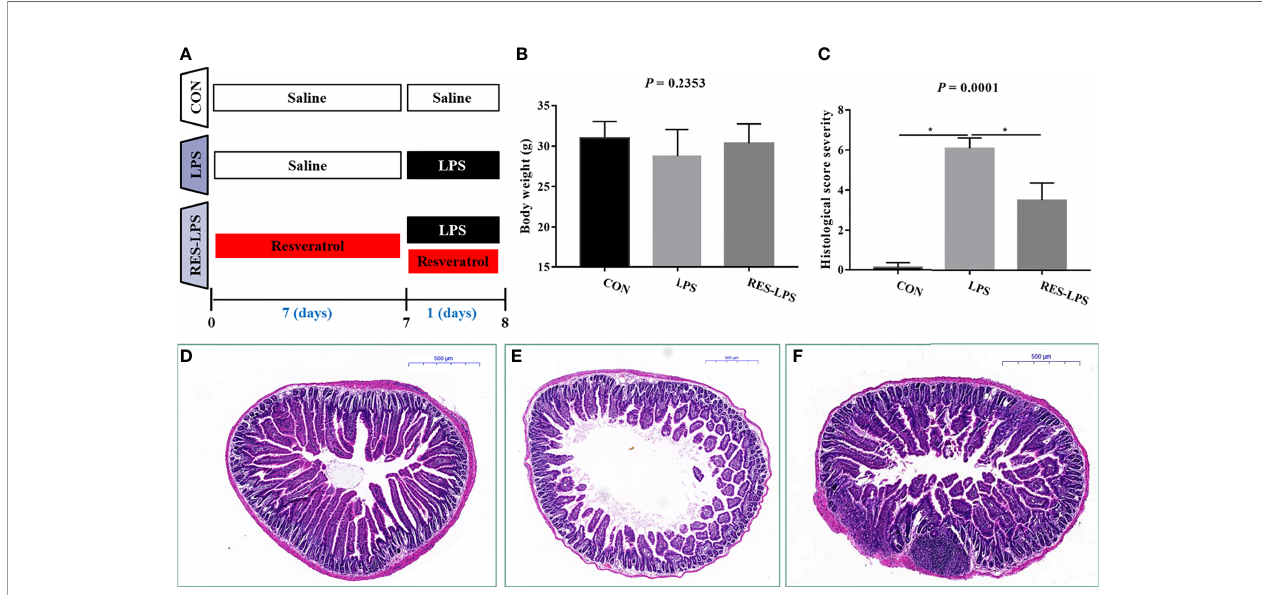
FIGURE 1 | Effect of RES on intestinal in fl ammation induced by LPS. (A) Timearrangement and treatment ofthisexperiment. (B) Final body weights ofthe micein the three groups. (C) Histopathological severity scores of the three groups. Effects ofRES onintestinal histology in the CON (D) , LPS (E) , and RES – LPS (F) groups, *p<